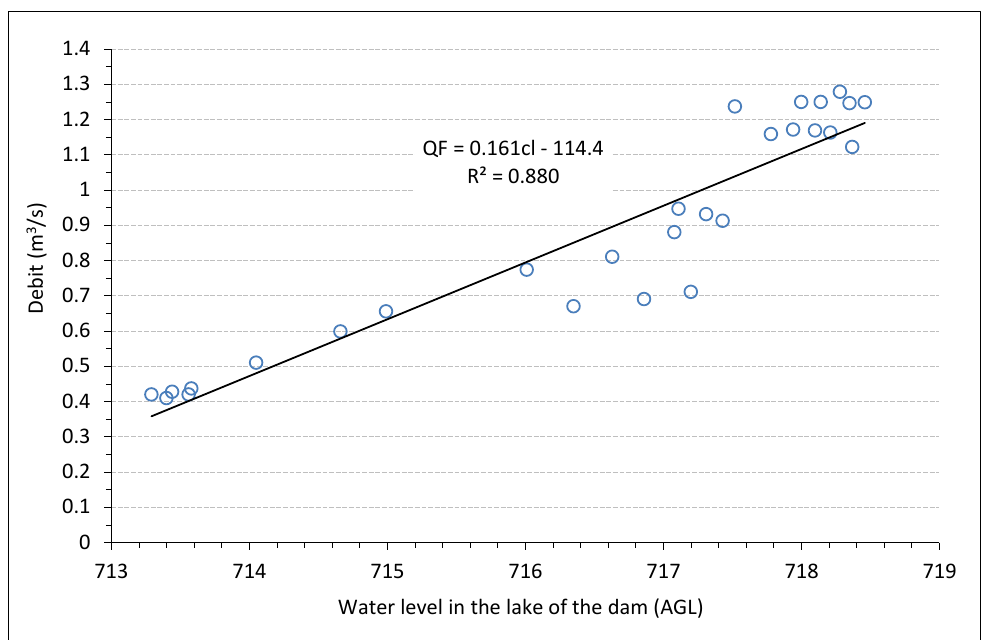
In order to obtain a relationship that relates the measured leakage rate and the level of the lake in the lake, we will represent the first one according to the second one. Figure 36 shows the variation in the flow of leaks as a function of the water level at the Hammam Grouz dam for grades ranging from 713 to 719 m.